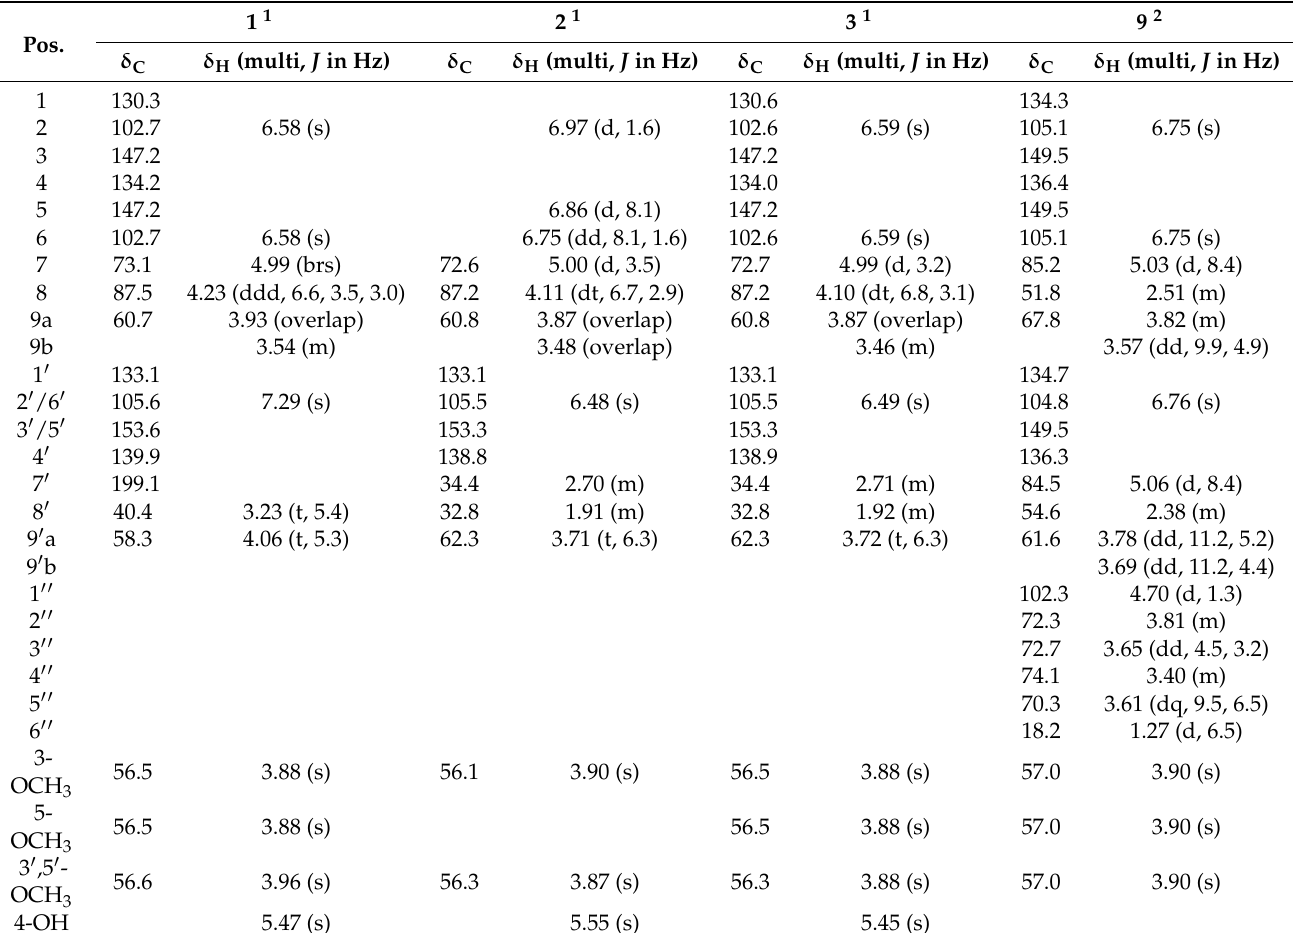
Table 1. 1 H (700 MHz) and 13 C (175 MHz) NMR data of compounds 1 – 3 , and 9 .